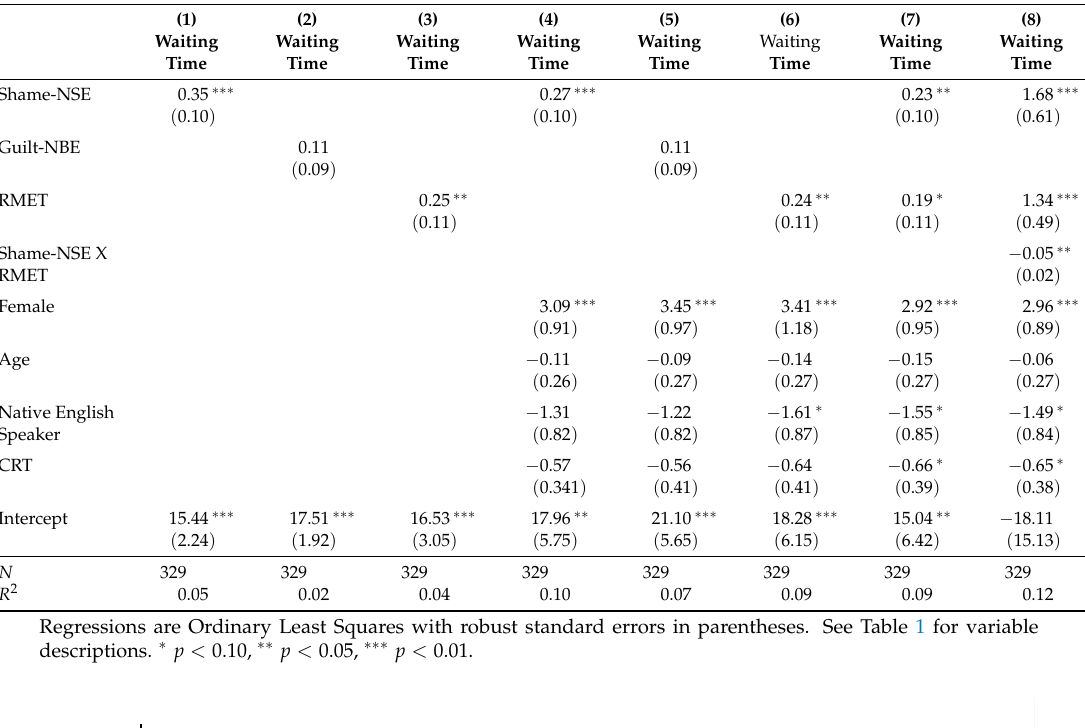
Table 4. Predicting waiting time by shame, guilt, and theory of mind (ToM): Regression results.